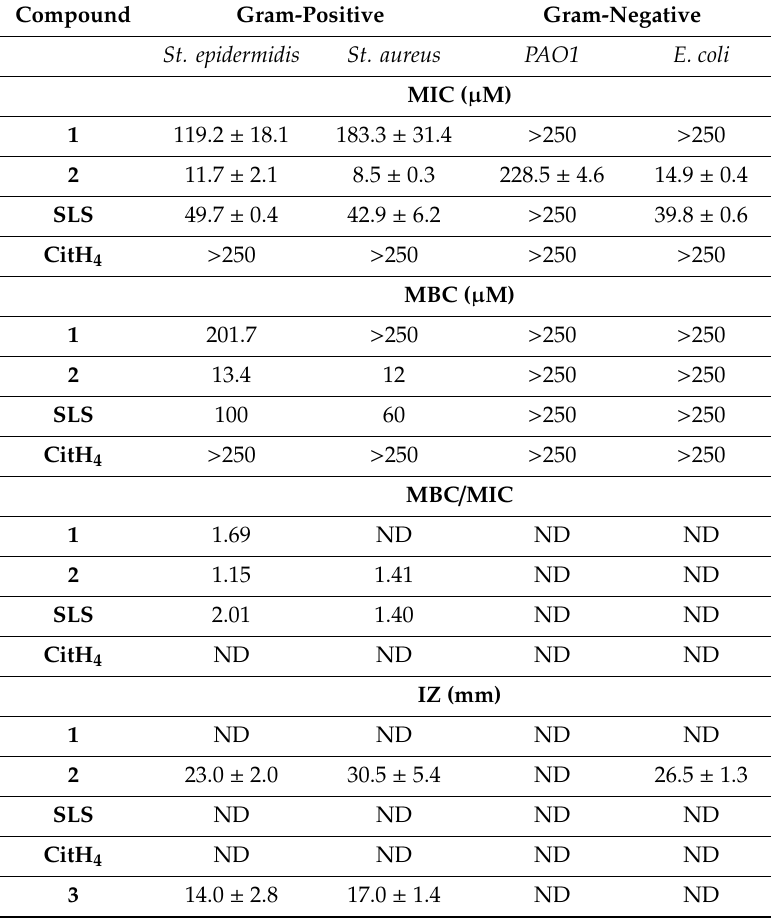
Table 1. Minimum Inhibitory Concentrations, Bactericidal Concentrations and Inhibition zones of 1 , 2 , SLS, and CitH 4 against St. epidermidis , St. aureus , PAO1 , and E. coli